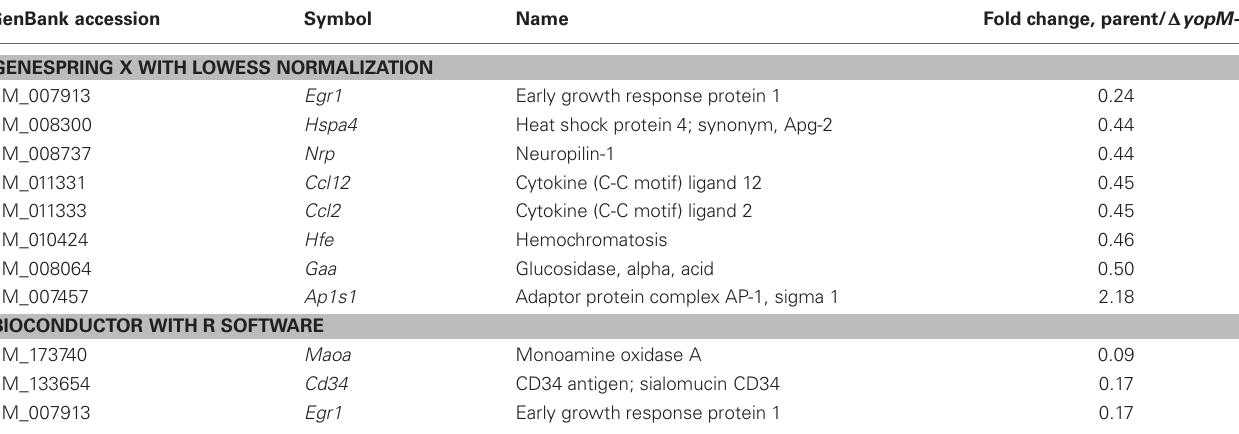
Table 6 | Microarray results for 1-h infection, analyzed two ways a . GenBank